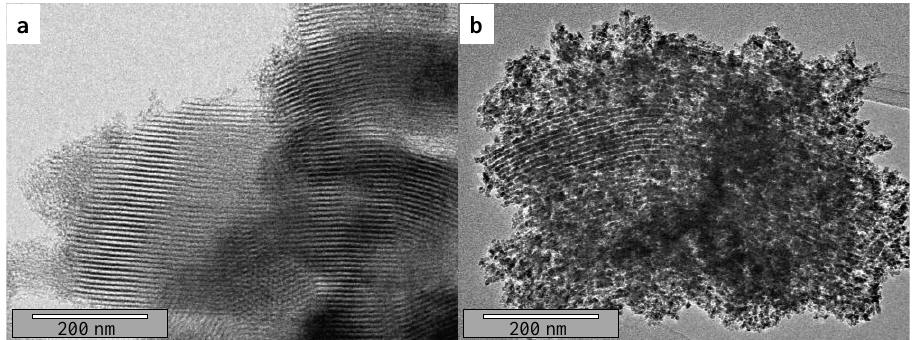
Figure 2. TEM micrographs of calcined ( a ) SBA-15 and ( b ) CeO 2 -m supports.